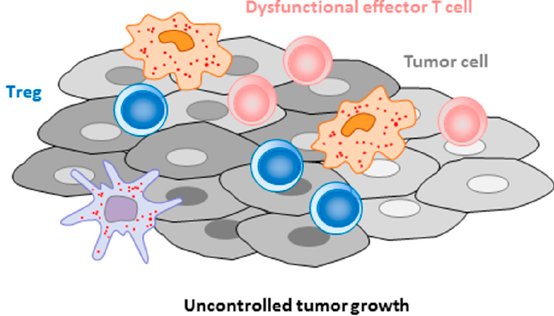
Figure 2. Role of IL4I1 in cancer immune escape. The presence of IL4I1-producing cells in the tumor cell microenvironment restrains the anti-tumor immune response by directly limiting the proliferation and functionality of cytotoxic T cells and Th1 cells, or indirectly by facilitating the accumulation of Treg cells. In murine models, the level of IL4I1 expression is associated with tumor growth. In melanoma patients, the presence of IL4I1-expressing cells in close contact with tumor cells correlates with parameters of poor outcome.